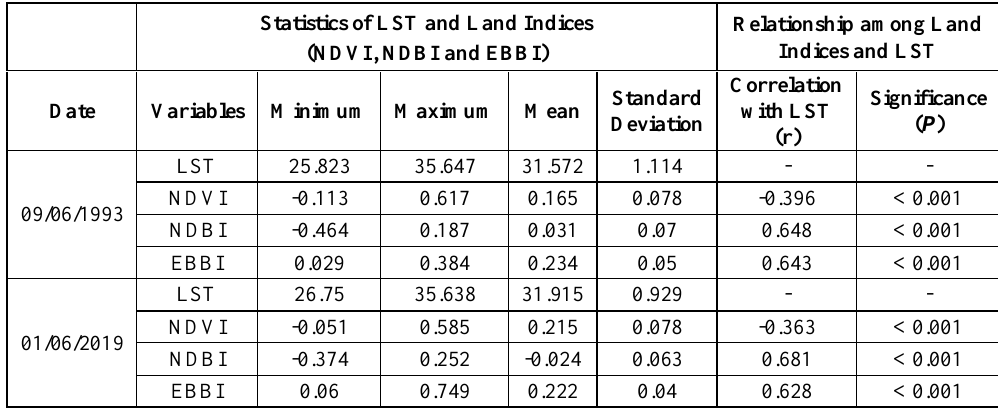
Table 2. Statistics of LST and Land Indices (NDVI, NDBI, and EBBI) with their correlation coefficients